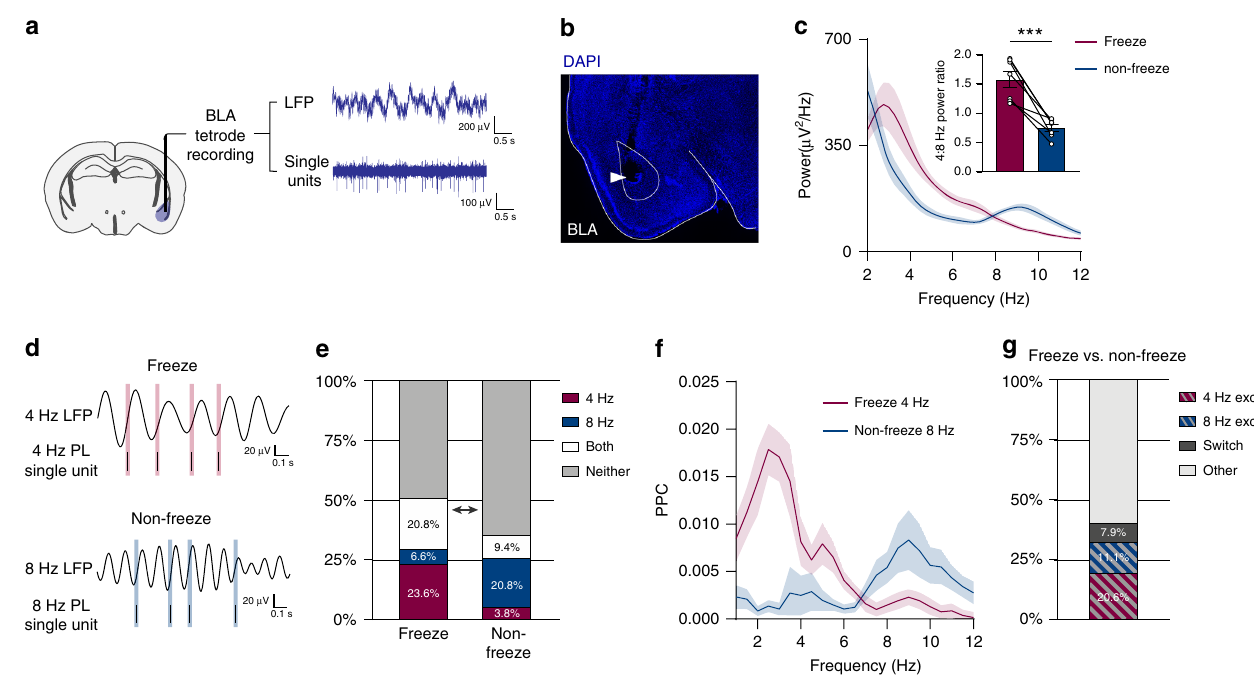
Fig. 1 4 Hz and 8 Hz oscillations differentially modulate local BLA spiking activity. a Experimental schematic. Thirty two channel tetrode drives were implanted into the BLA to extract both LFP and spiking activity in mice while subjected to fear conditioning and extinction. b Example histology image showing tetrode placement after electrolytic lesion. c Averaged BLA power spectra during freezing and non-freezing periods used for phase-locking analysis. Inset: quanti fi cation as 4:8 Hz power ratio (paired two-tailed t -test: P = 0.0007, t (6) = 6.31, n = 7 mice). d Example BLA single units that signi fi cantly phase-locked (PL) to BLA LFP at 4 Hz during freezing or 8 Hz during non-freezing (signi fi cance based on permutation test P < 0.05;